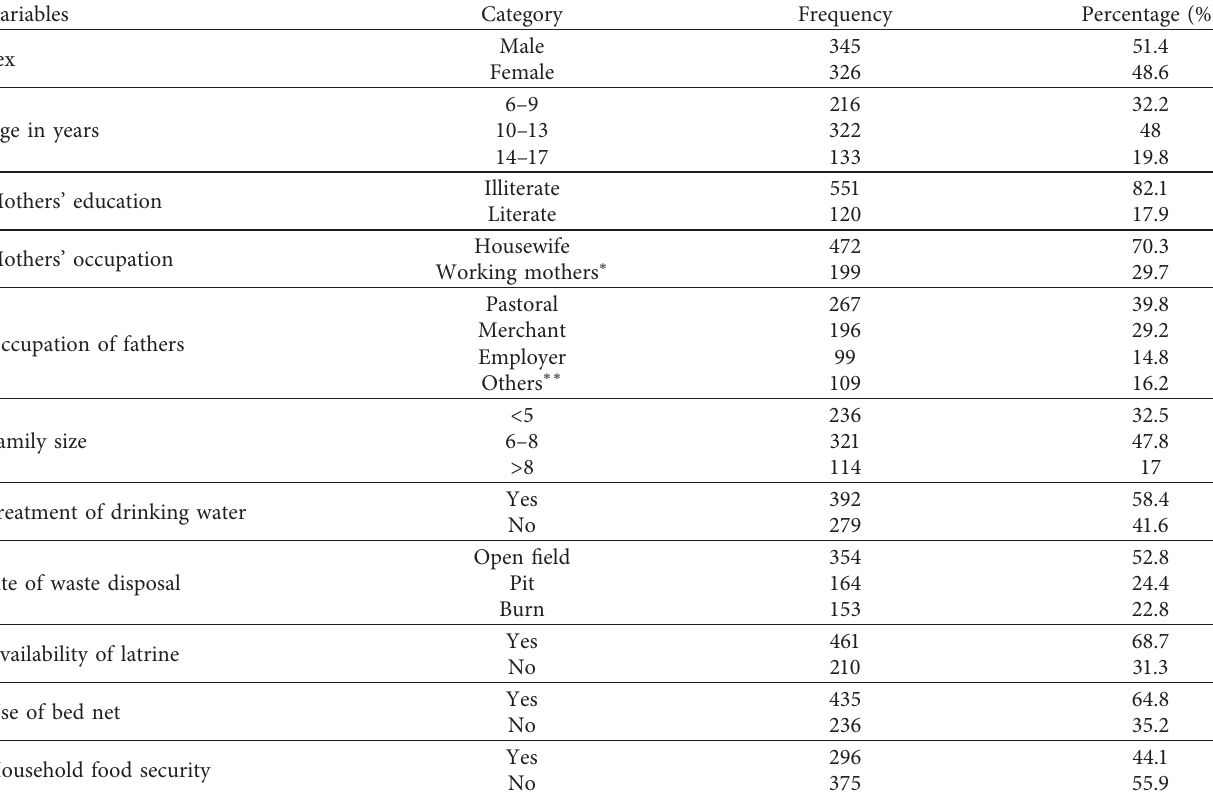
Table 1: Sociodemographic and household characteristics of children attending primary schools in pastoral communities, Mieso-Mulu district, Sitti Zone, Somali Regional State, Eastern Ethiopia, 2019.